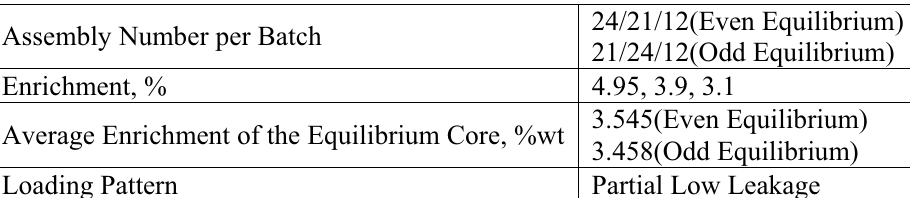
Table IV.: Fuel Management Design of Boron-Free Core